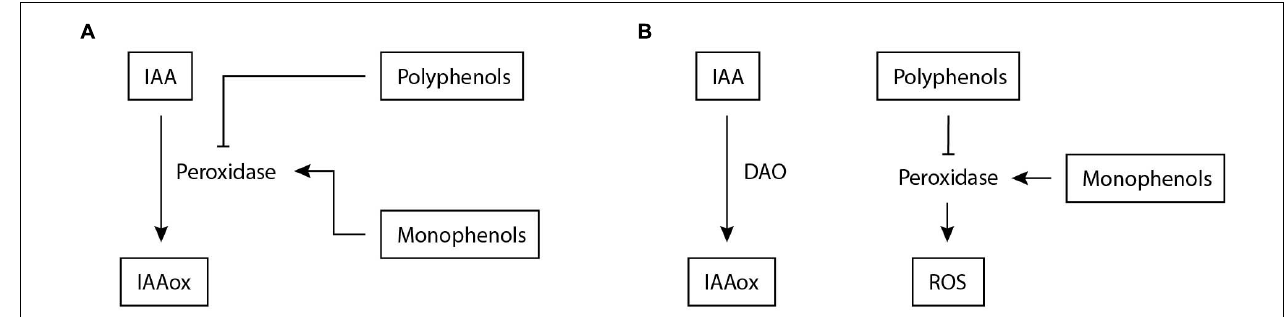
FIGURE 3 | Proposed mechanisms involved in IAA inactivation during nematode infection of plants. (A) Previously, a mechanism was suggested for IAA inactivation during nematode infection based on (Giebel, 1970; Giebel, 1974; Giebel and Lamberti, 1977). Peroxidase is assumed to facilitate the conversion of IAA to IAAox, which is stimulated by increased monophenols levels and inhibited by polyphenols. (B) Based on new insights (Normanly et al., 1995), an alternative model for IAA inactivation is proposed. DAO facilitates IAA oxidation, but it is anticipated that additional inactivation mechanisms are involved. In this model, peroxidases remain regulated by phenols but now enhance ROS production as reported by Simonetti et al. (2010); Jin et al. (2011), and Sung et al. (2019). IAA, indole-3-acetic acid; IAAox, oxidized indole-3-acetic acid; DAO, DIOXYGENASE FOR AUXIN OXIDATION; ROS, reactive oxygen